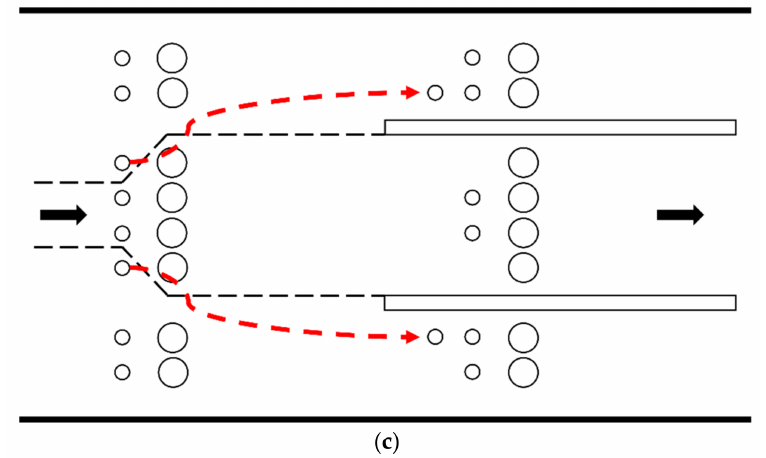
Figure 1. Isokinetic sampling condition classification: ( a ) super-isokinetic sampling, ( b ) isokinetic sampling, and ( c ) sub-isokinetic